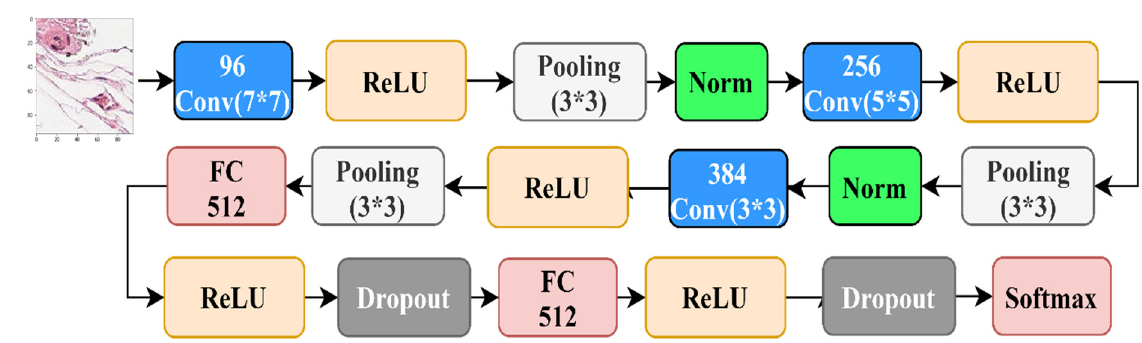
Figure 8. The architecture of Bayramoglu et al. [21].